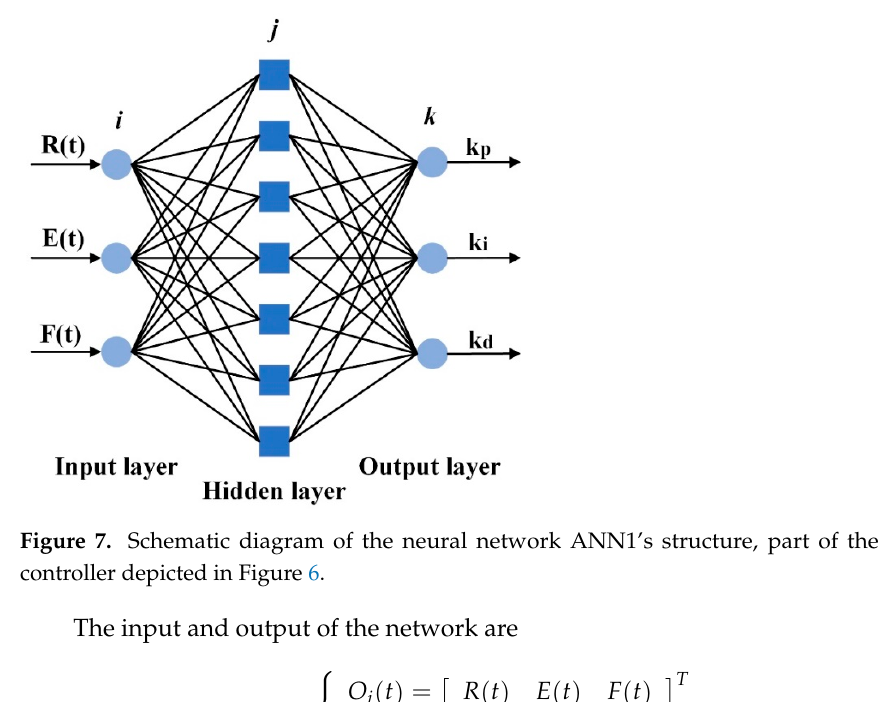
Figure 6. Backpropagation neural network-Smith predictor-proportional–integral–derivative (BPNN-SP-PID) controller structure diagram.